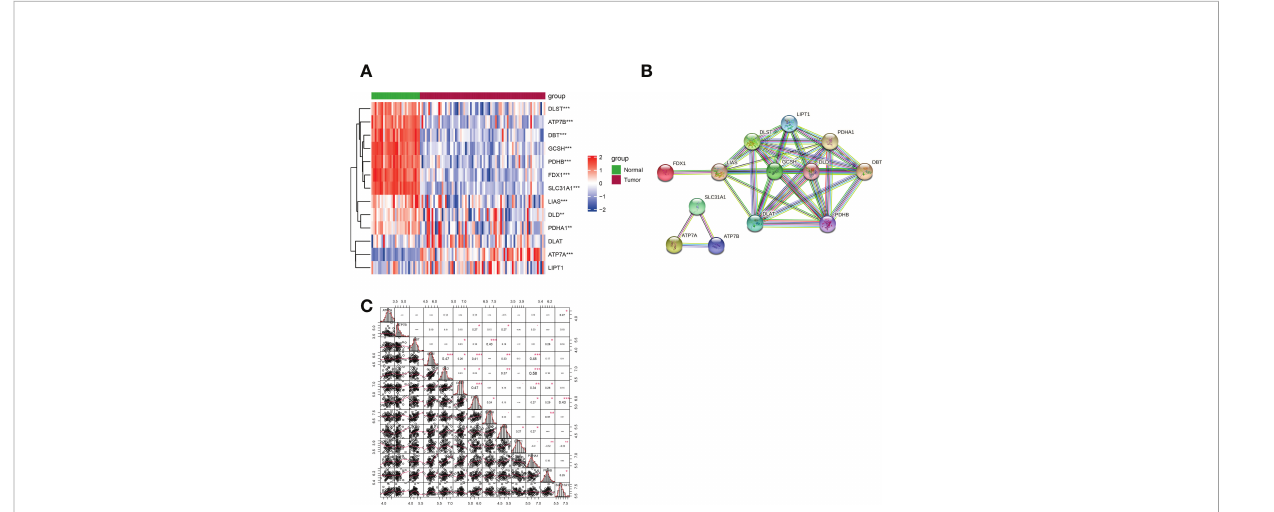
FIGURE 2 Expression of CRGs and interactions among them. (A) Heatmap showing the expression of CRGs in CCA and normal samples (red: upregulation; blue: downregulation; P values are shown as *p < 0.05, **p < 0.01, ***p < 0.001). (B) PPI network demonstrating the interactions of the CRGs (average local clustering coef fi cient=0.962). (C) The correlation plot of the